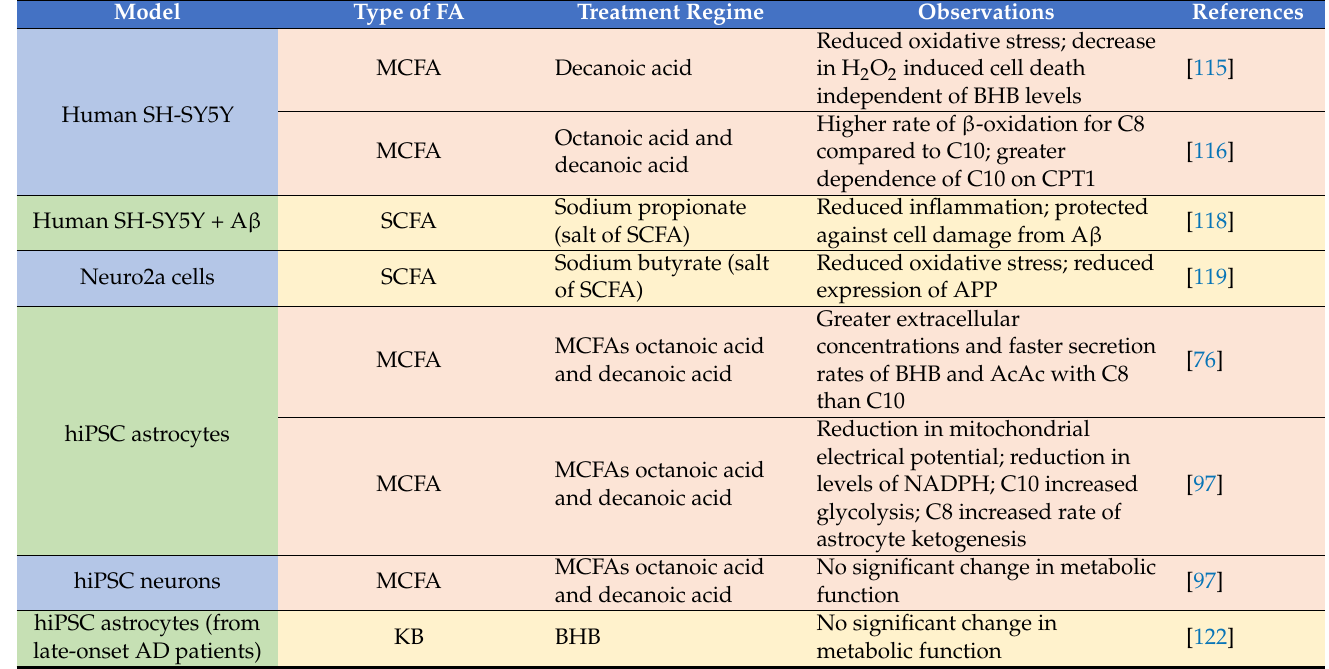
Table 2. Comparison of current cellular models studying SCFAs and